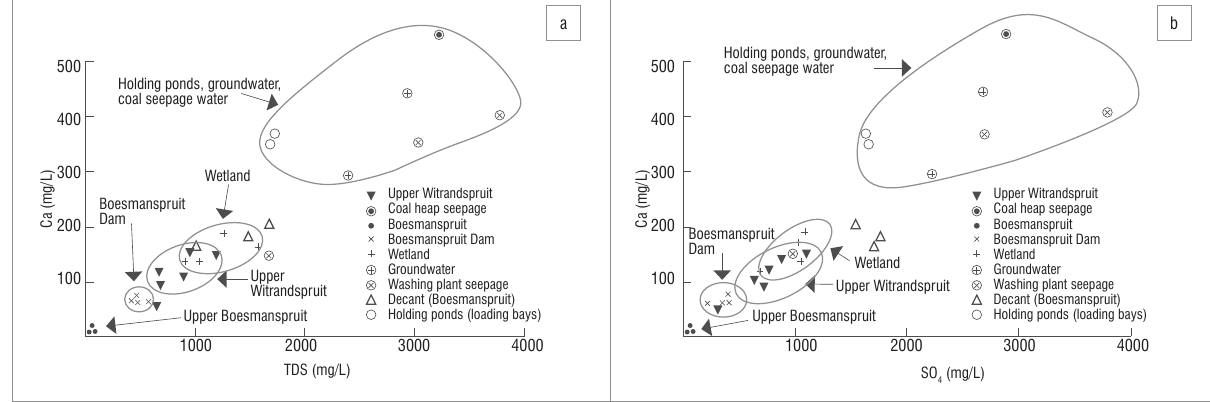
Figure 8: Plots of (a) calcium (Ca) against total dissolved solids (TDS) and (b) Ca against sulphate (SO